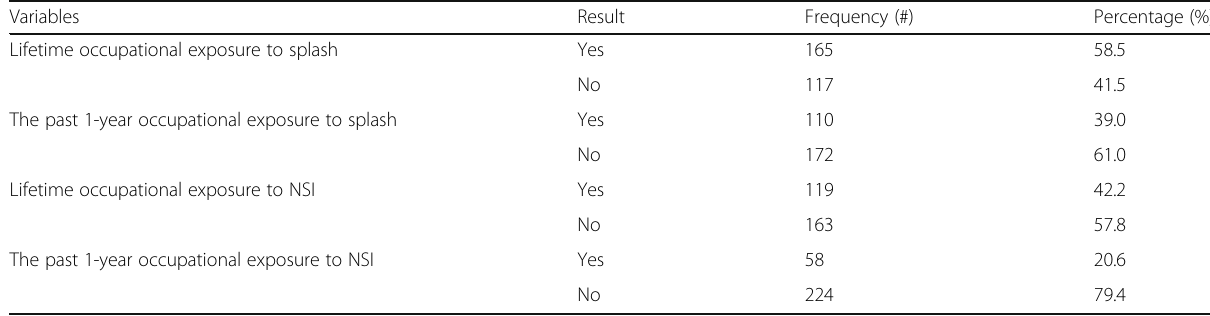
Table 2 Frequency of occupational BBFs splash and NSI exposure among health care workers Variables